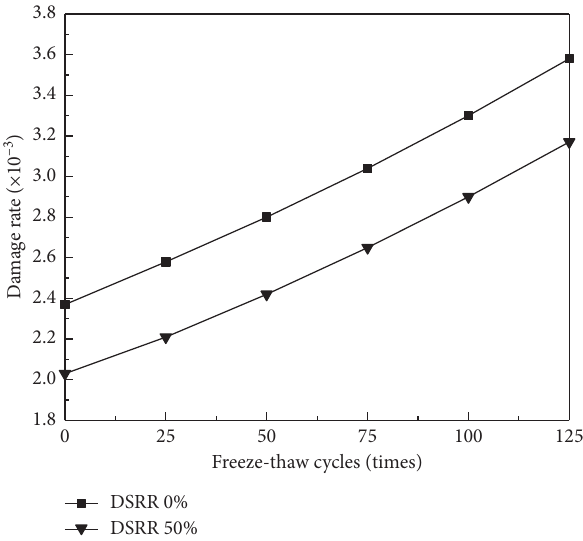
n and freeze-thaw cycles.